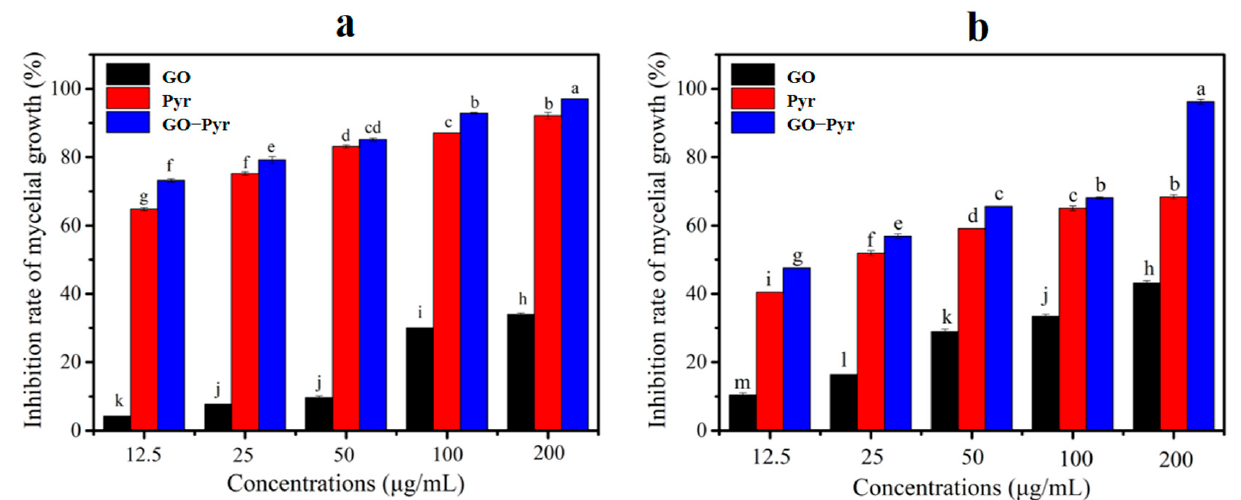
Figure 7. Synergistic effects of GO, Pyr and GO–Pyr nanocomposite on the mycelial growth rate of FG ( a ) and SS ( b ). Different lower case letters indicate significant differences between treatments ( p < 0.05).